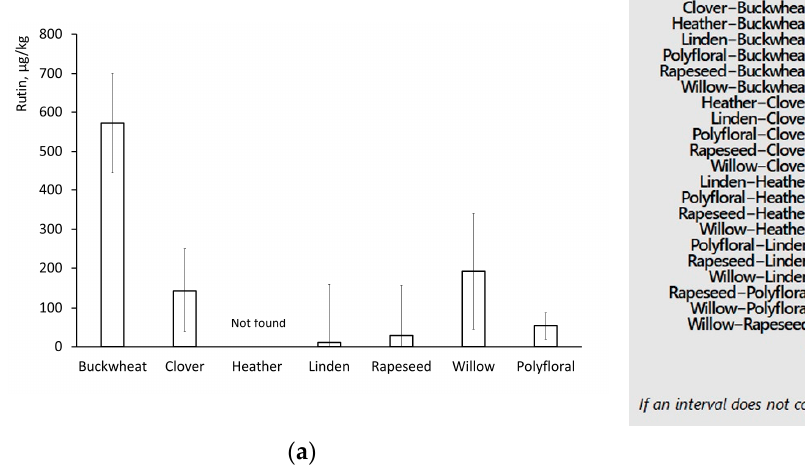
Figure 2. One-way ANOVA test of statistically significant difference between monofloral buckwheat, clover, heather, linden, rapeseed, willow, and polyfloral honey ( a ) using interval plot ( μ g/kg) as graphical summary with 95% confidence interval bars, and ( b ) using Tukey comparison of 95% confidence intervals. Table 2. Comparison of chemical compound mass concentrations ( µ g/kg) quantified by UHPLC- HRMS that share statistically significant differences between groups of floral origins.